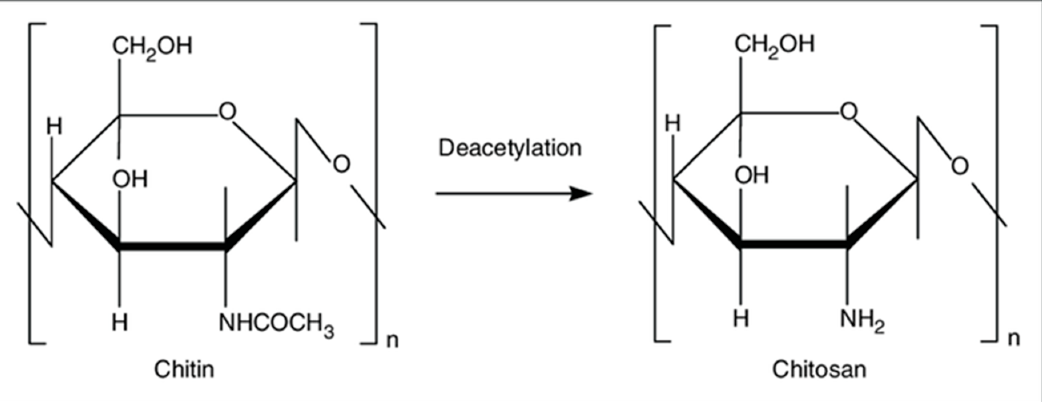
Figure 1. Chitin and chitosan structure.